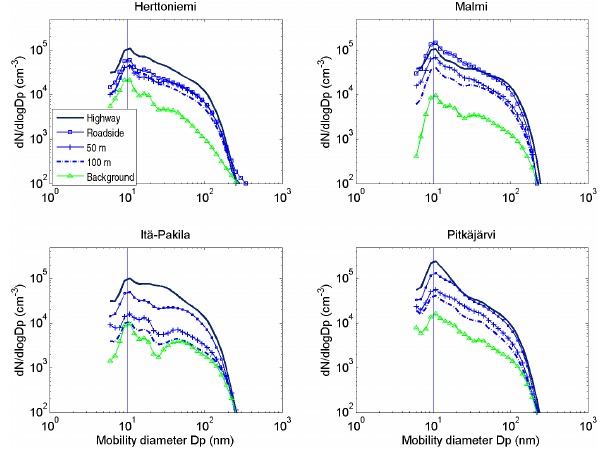
Figure 3. Particle size distribution as measured by the EEPS at dif- ferent distances from the roadside at the four locations.